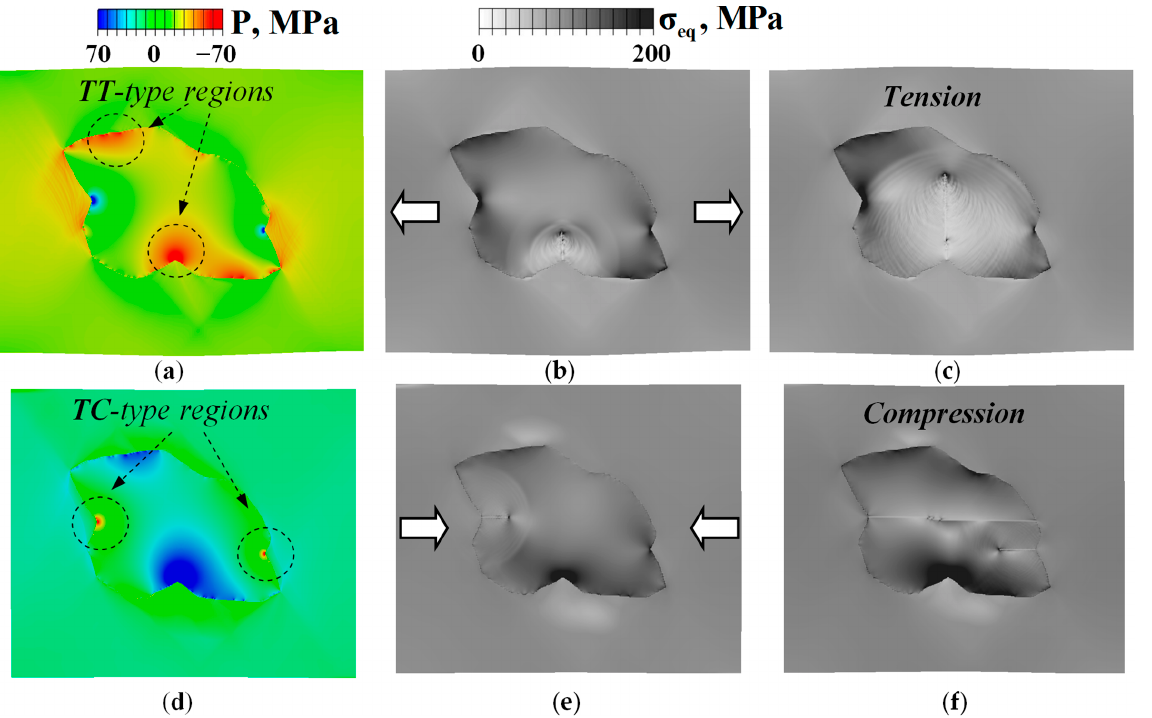
Figure 2. Pressure patterns in the prefracture stage ( a , d ) and crack propagation under tension ( b , c ) and compression after cooling of the Al6061-WC composite ( e , f ). Video data files “Fig2Ten.avi” and “Fig2Com.avi” are available online in Supplementary Materials.